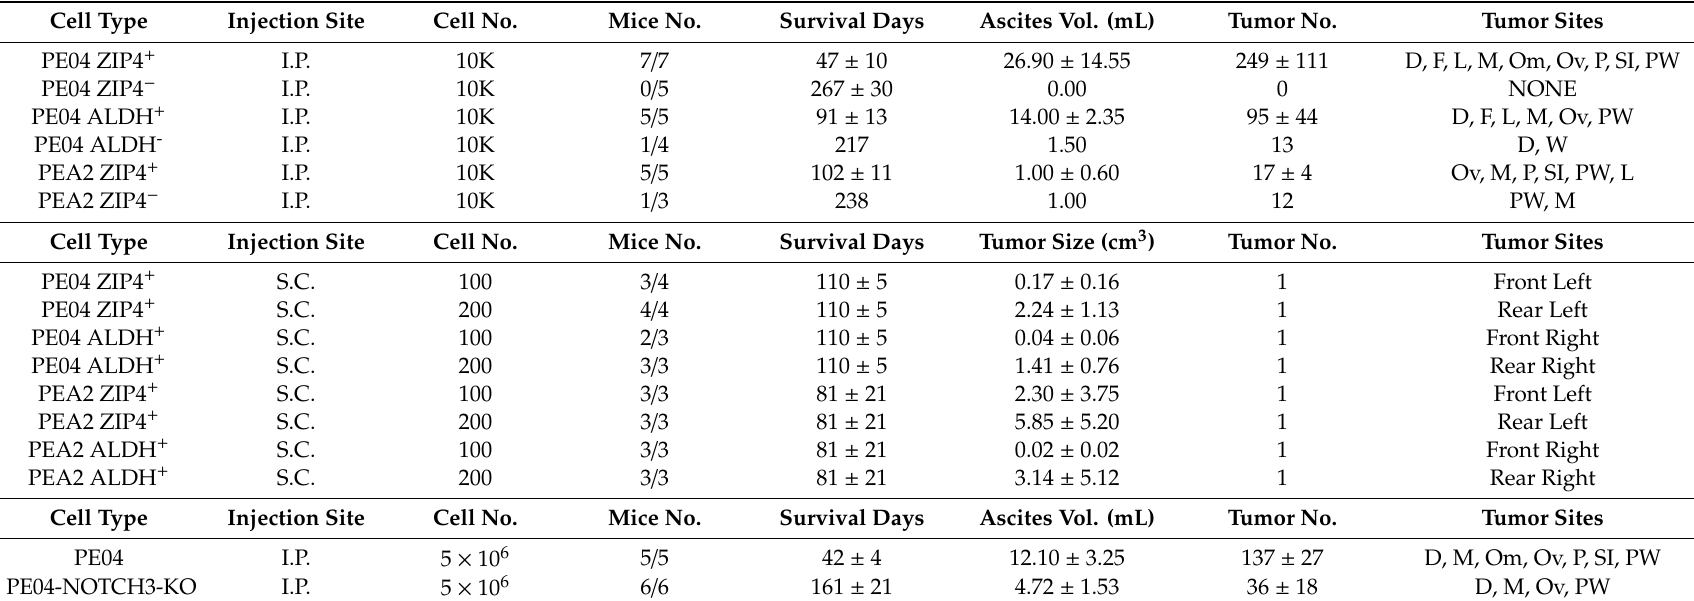
Table 1. Summary of tumor formation abilities of di ff erent groups of cells in